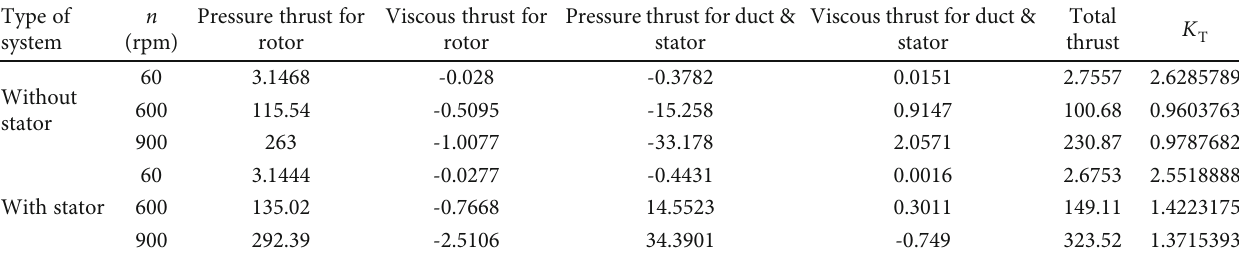
Table 12: Thrust force calculated for the linear jet system in bollard pull mode.